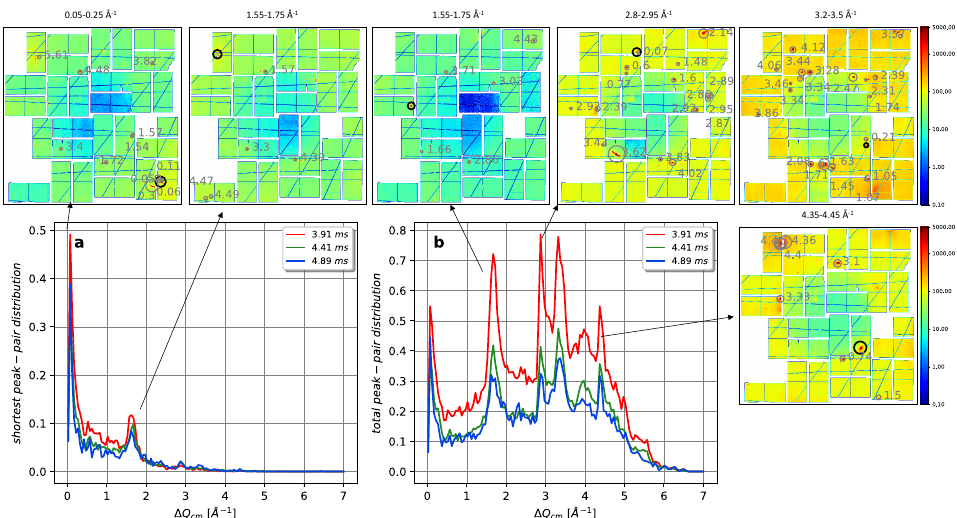
Figure 4. Peak-pair distributions as a function of a center of mass difference in reciprocal space ( ∆ Q cm ) for ( a ) shortest ∆ Q cm and ( b ) all peaks in the ice hits above 50 ADU/pixel. Random hits that contain the most probable ∆ Q cm (1.55–1.75, 2.8–2.95 and 3.2–3.5 Å − 1 ) are shown as examples. The black-marked peak in each shot is the reference peak and the correlated ∆ Q cm from the reference peak to the other neighboring peaks in the same shot is written on top of each corresponding peak.